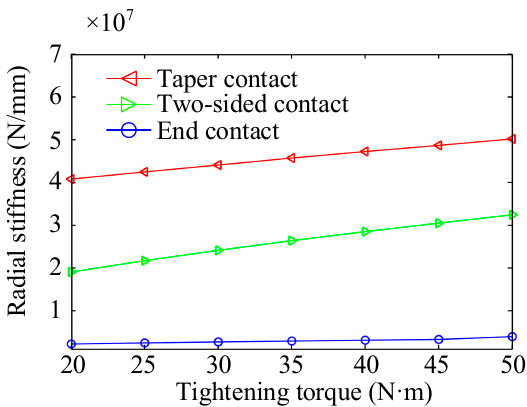
Figure 16. Radial stiffness under different contact states. Here, the root mean square (RMS) of the time-frequency vibration signal was used to describe the vibration amplitude. The RMS values of spindle radial vibration for the three original contact states are shown Figure 17 . It can be seen that the RMS of radial vibration displacement of the spindle in the three original contact states is the smallest in the tapered contact, the second largest in the two-face contact, and the largest in the end-face contact. This is consistent with the law that states that the greater the stiffness of the spindle–GWF interface, the smaller the vibration. As the tightening torque increases, the RMS values in the three original contact states decrease. This law has the same trend as the effect of the tightening torque on the radial stiffness of the spindle–GWF interface, but the degree of reduction is different. This is because the spindle vibration is not only related to the contact stiffness of the spindle–GWF interface, but it is also affected by the contact state of the spindle–GWF interface. As can be seen from Figure 8, when the end clearance is 20 μ m and the tightening torque is less than 40 N · m, the contact state of the spindle–GWF interface after assembly is end contact, and the tapered surface is not in contact. The lack of radial positioning between the spindle and the GWF results in poor radial stability of the spindle and expansion of the spindle radial vibration. As the tightening torque increases, the tapered contact area increases and radial vibration decreases rapidly. It is also indirectly verified that the spindle operation is more stable when the spindle–GWF contact state is two-sided contact after assembly.